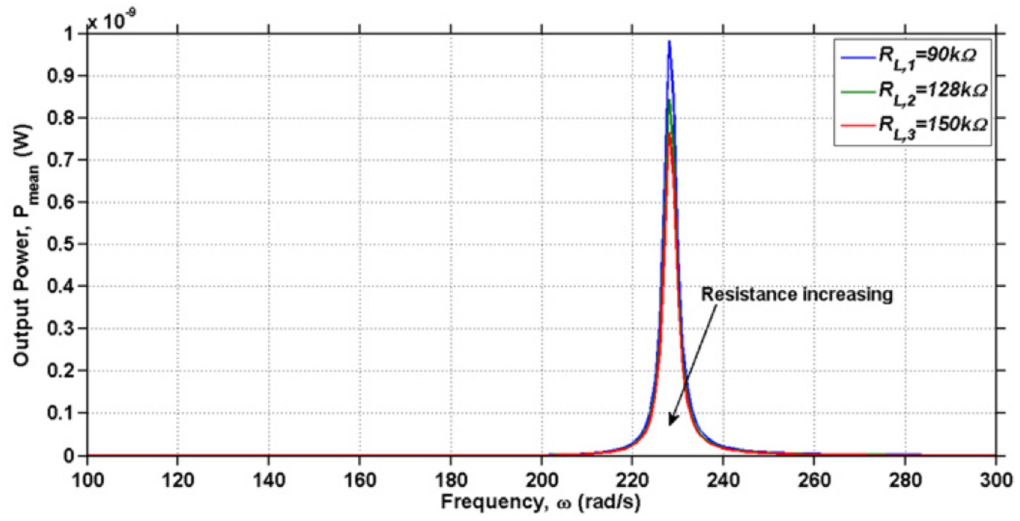
Figure 14. Mean power output of the EAPap‐based energy harvester for a range of frequencies with different external resistive loads [79].